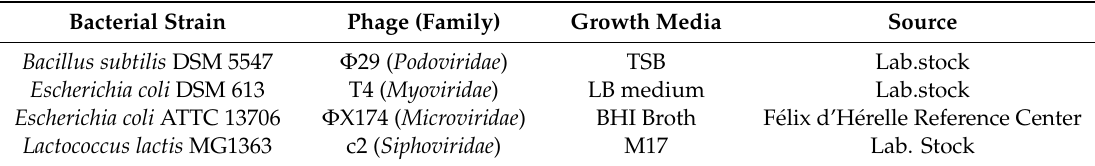
Table 1. Bacterial strains and their respective